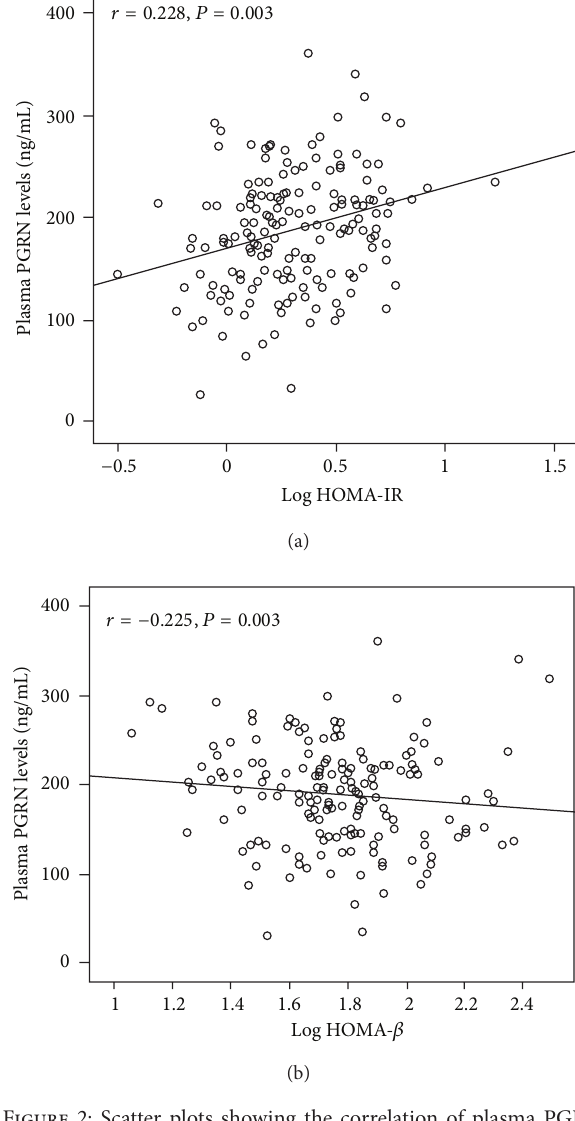
Figure 2: Scatter plots showing the correlation of plasma PGRN levels with HOMA-IR and HOMA- 𝛽 in all subjects. (a) The plasma PGRN levels positively correlated with HOMA-IR. (b) The plasma PGRN levels negatively correlated with HOMA- 𝛽